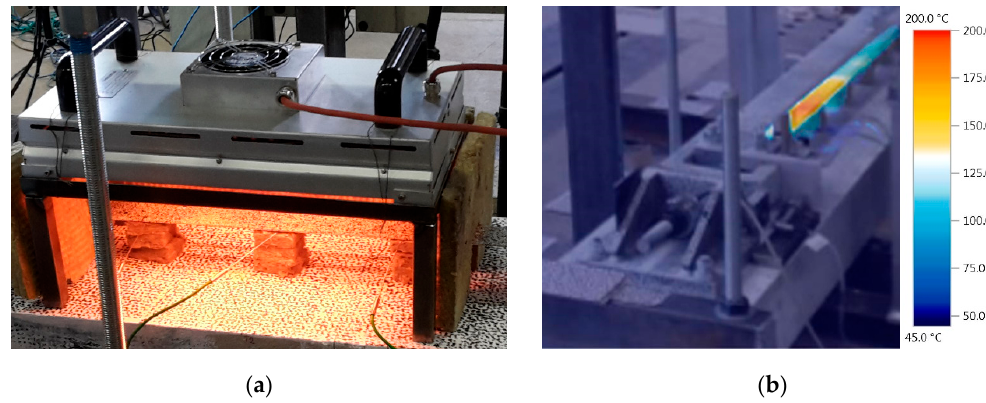
Figure 6. ( a ) Infrared emitter used as heating device for activation of SMA; ( b ) temperature monitoring using infrared camera (picture without correction of emissivity).